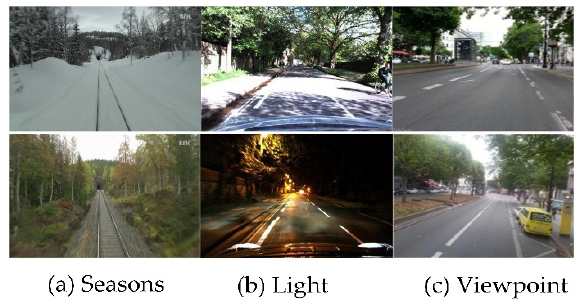
Figure 2. Change in appearance of places due to variation in ( a ) seasons [125], ( b ) light [124], and ( c ) viewpoint [126].